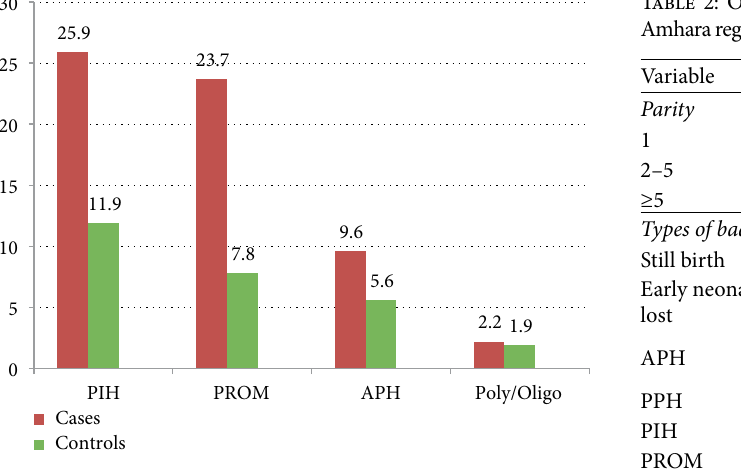
Figure 1: Distributions of obstetric complication in the index pregnancy among women who gave birth in Amhara region referral hospitals, Northwest Ethiopia,